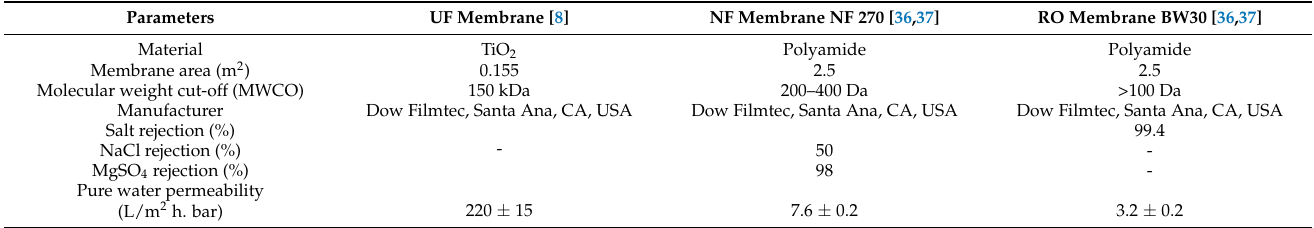
Table 1. Membrane